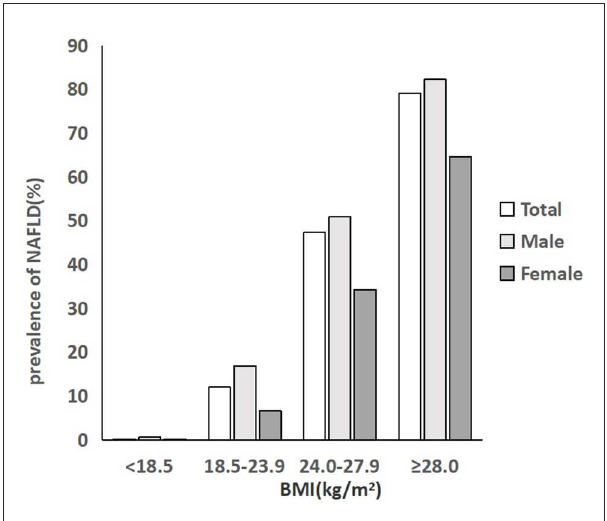
FIGURE2 Prevalence of NAFLD in different BMI